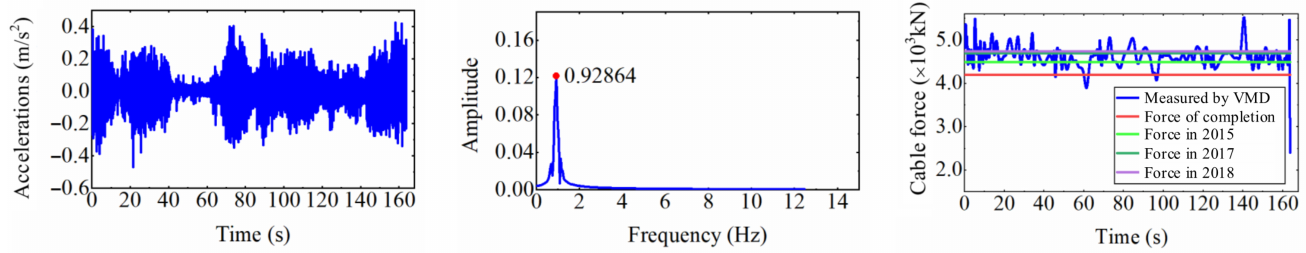
Figure 17. Acceleration signal, vibration spectrum and time-varying force of the A15 cable in the time interval of 09:00–09:30 on 12 October